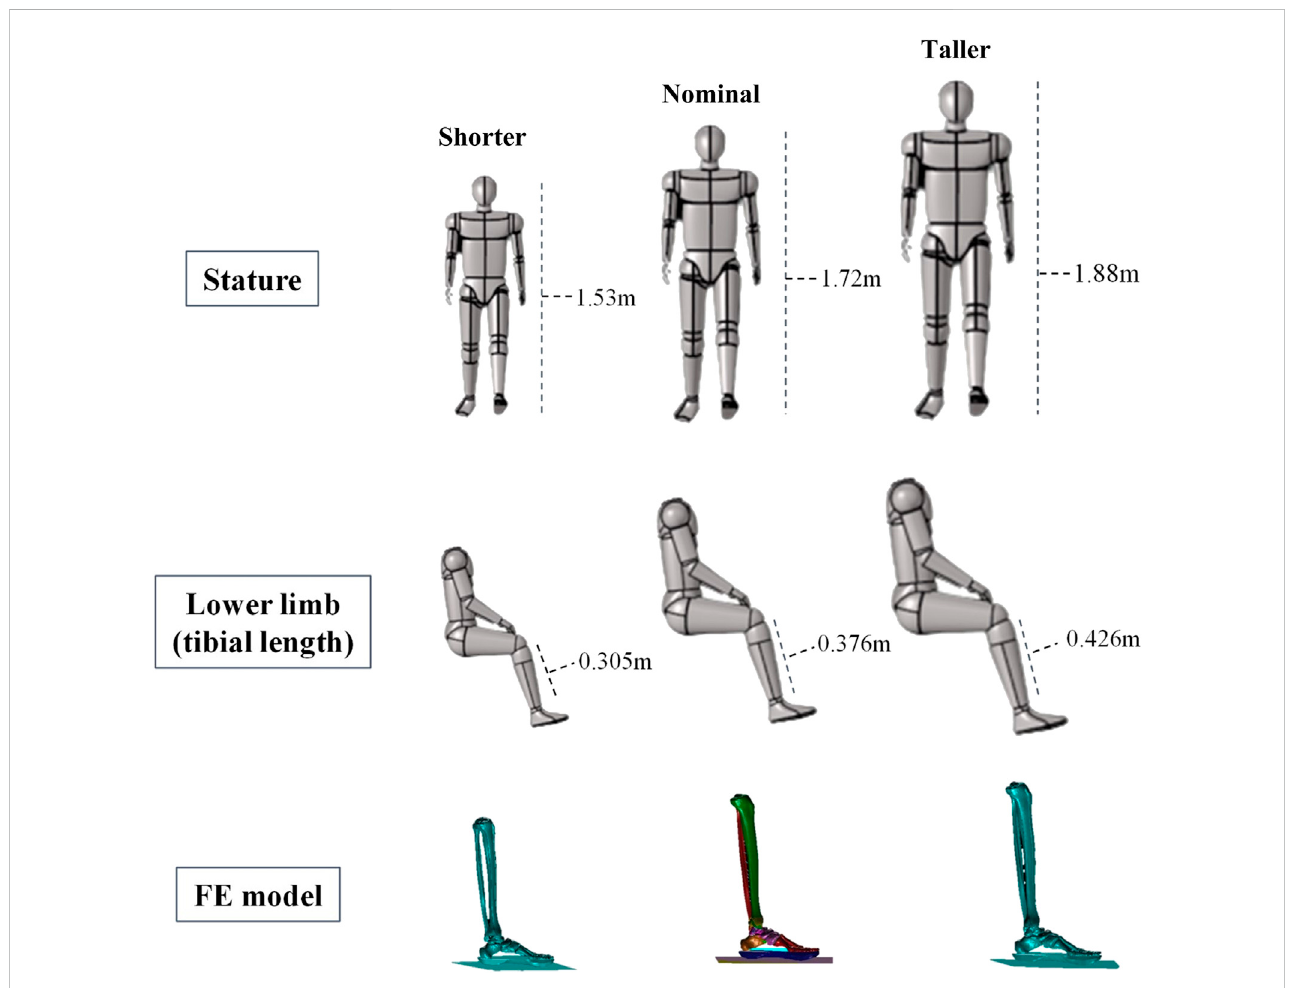
FIGURE 2 Short, nominal, and tall statures used for the anthropometric study. They were selected based on the military stature interval reported by Darter et al.